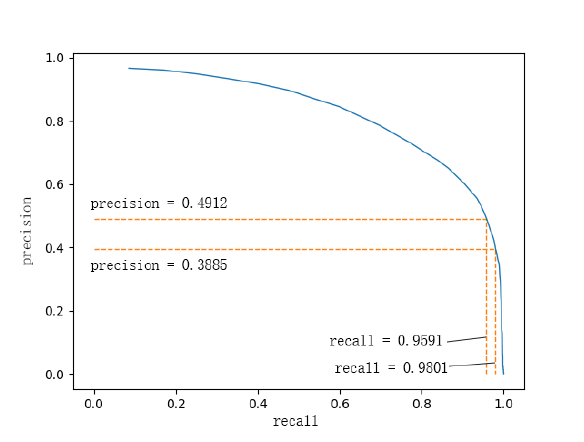
Figure 7. Precision-Recall curve of the ANN model’s outputs With different confidence thresholds, the ANN model presents different precision and recall values, which are shown by the P- R curve in Figure 7. Every point on the P-R curve represents a possible solution for the classification task. The area under the P-R curve represents the average precision of when different confidence thresholds are selected (Sahiner et al., 2017). In this case, our average precision is